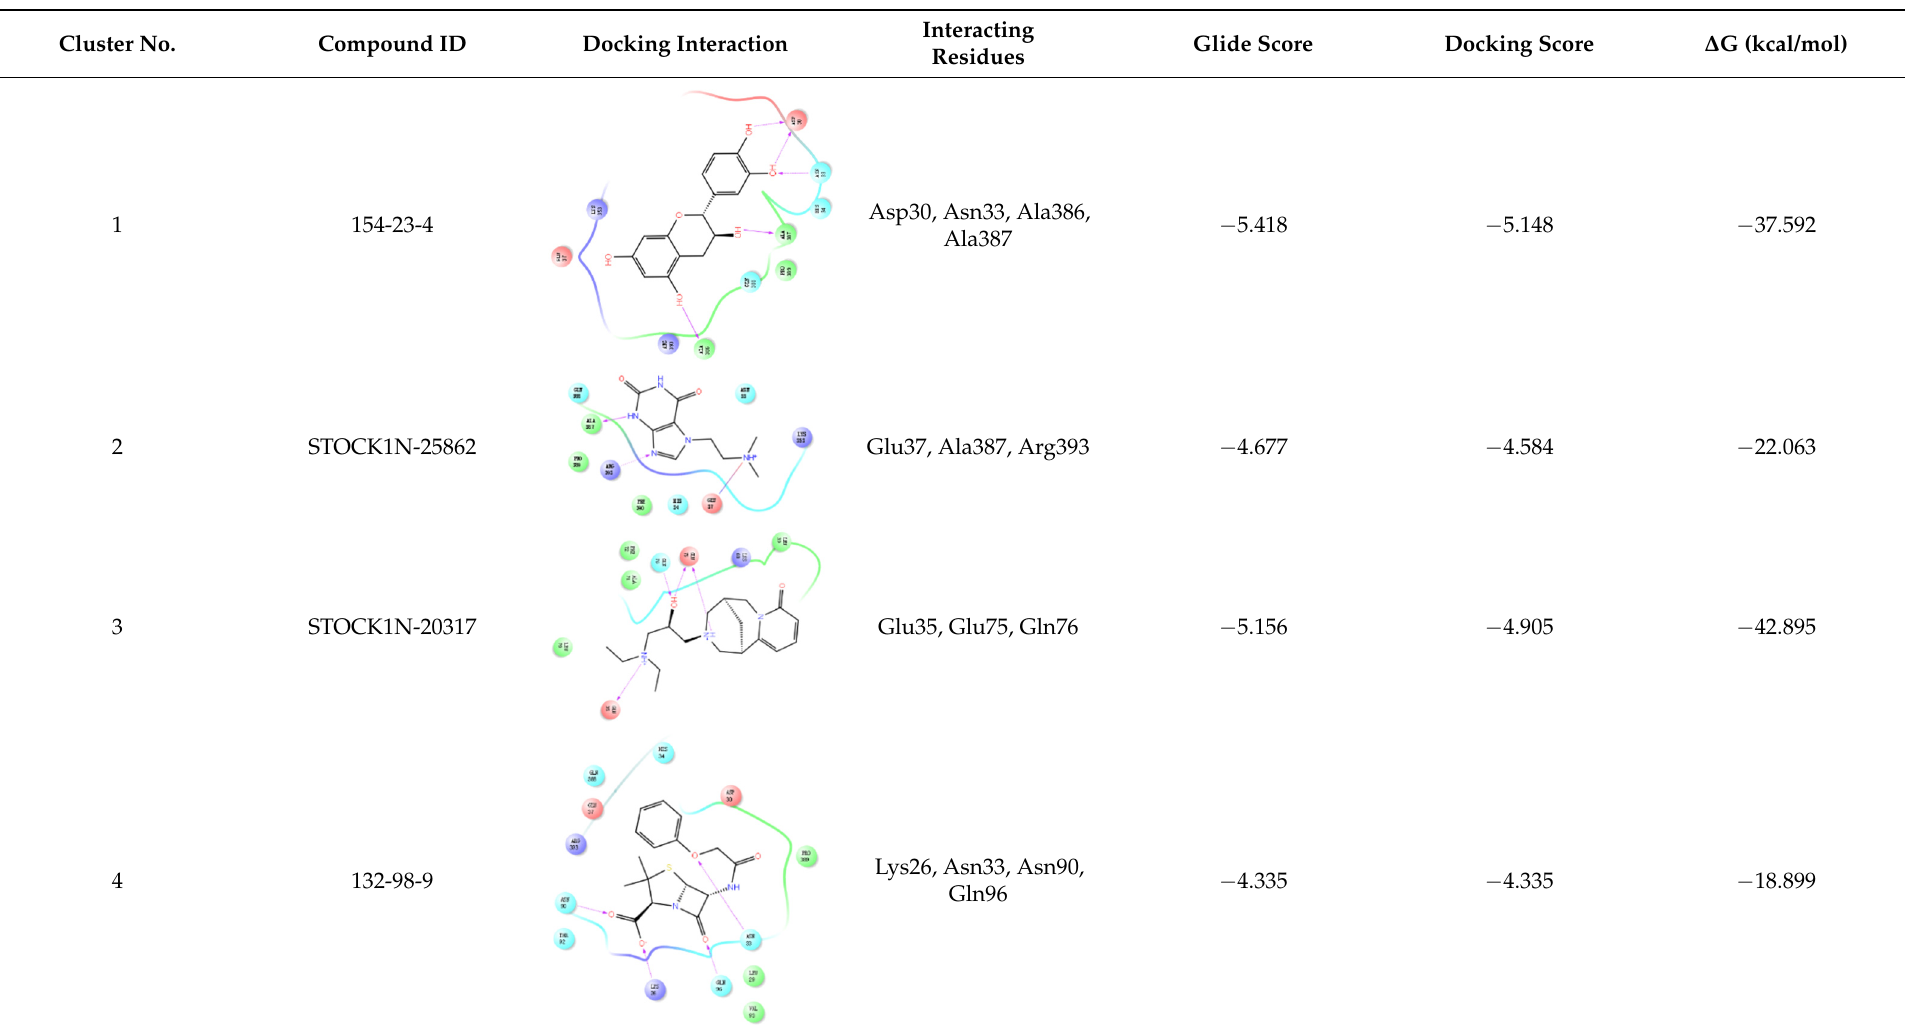
Table 3. The results of docking and interaction residues between the top 12 ligands and ACE2.